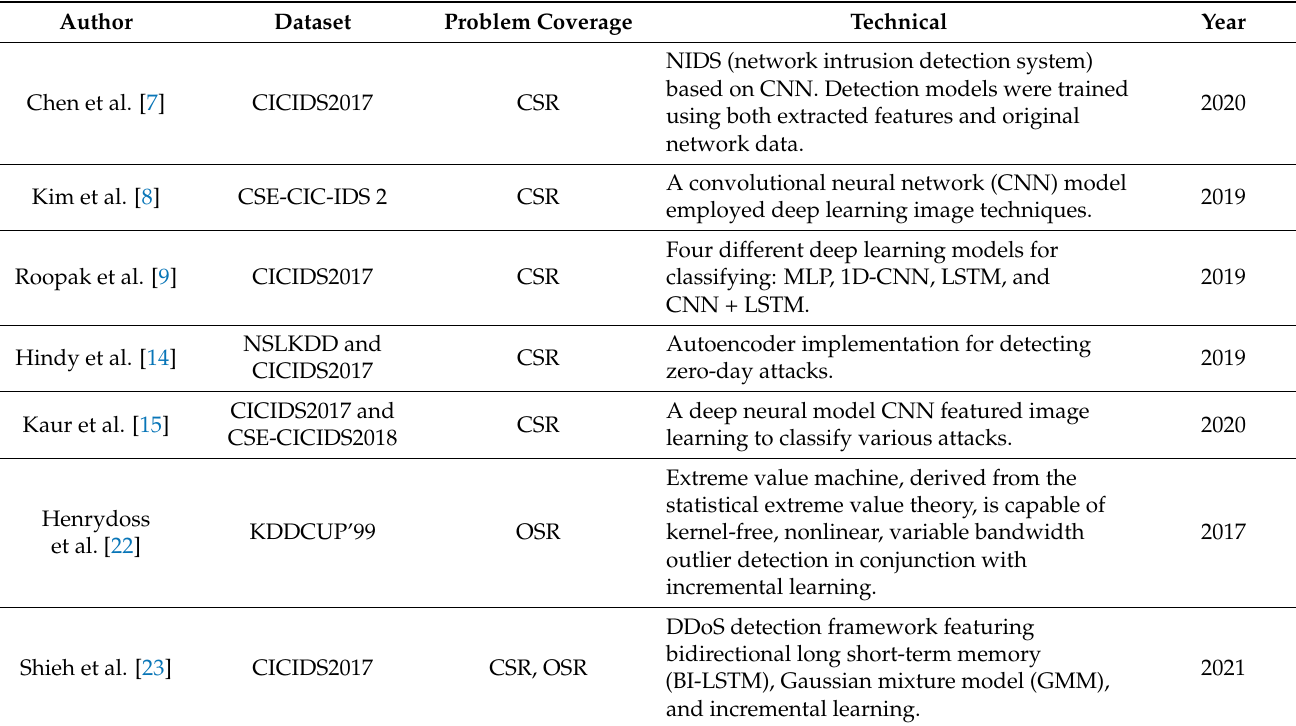
Table 1. Notable work related to deep learning techniques implemented for DDoS